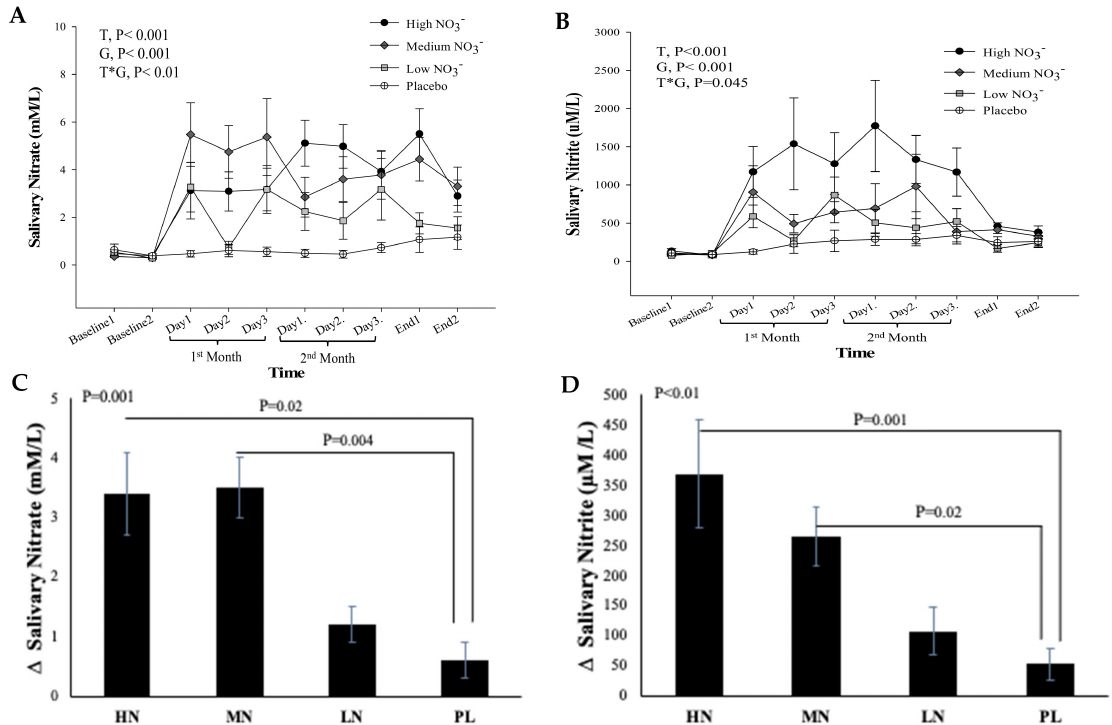
Figure 5. Salivary NO 3 − and NO 2 − concentrations in older overweight and obese adults. ( A , B ) Mean salivary NO 3 − and NO 2 − concentrations measured at baseline, 4 weeks, 8 weeks, and after 13-weeks for each of the intervention groups, respectively. ( C , D ) The mean change in salivary NO 3 − and NO 2 − concentrations between baseline and week 13 for each if the intervention groups, respectively. HN (High NO 3 − ; two 70 mL shots of BJ/day, morning and evening), MN (Medium NO 3 − ; 70 mL of BJ/day), LN (Low NO 3 − ; 70 mL of BJ every alternate days) and PL (placebo; 70 mL of NO 3 − depleted BJ). Each shot of BJ contains 400 mg of NO 3 − ( A , B ) Data were analysed using a 2-factor repeated measures ANOVA (time*group of intervention). ( C , D ) These changes of from baseline were analysed with one-way ANOVA. Data are expressed as mean ± SEM, ( n =